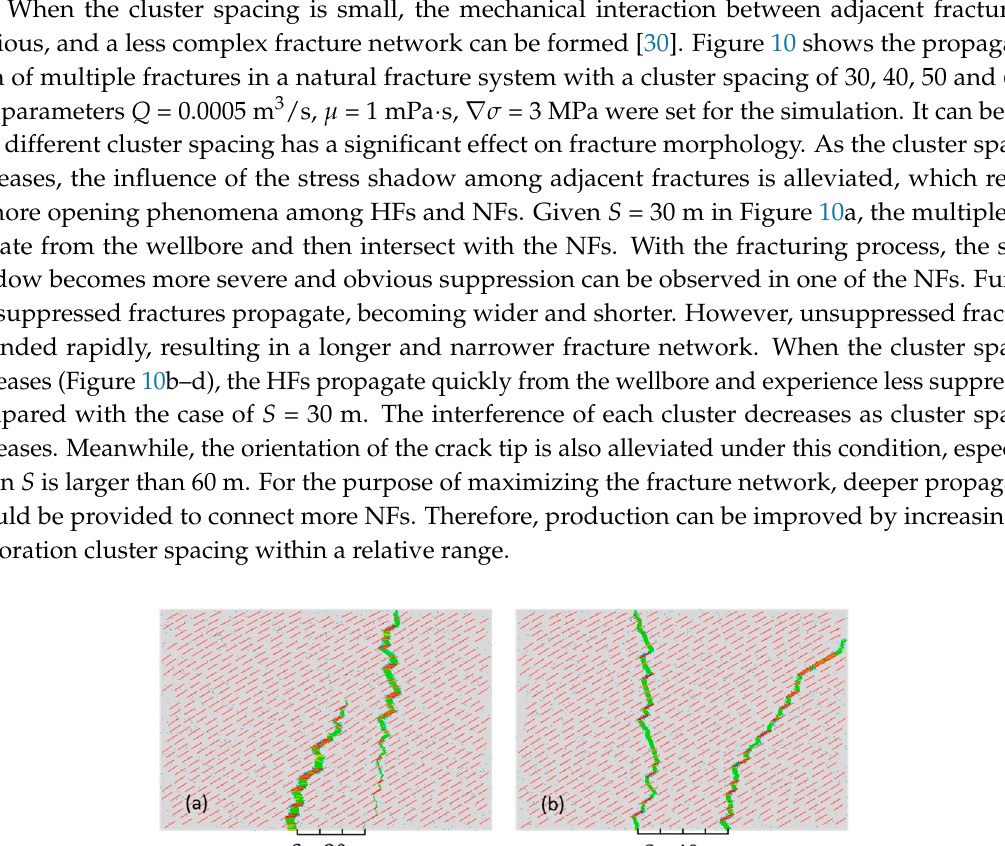
Figure 11. Fracture network lengths at different cluster spacing distances. 3.4. Injection Rate of Fracturing Fluid The influence of the fracturing fluid on the geometric shape of HFs can be expressed by the injection rate and fluid viscosity. In this section, the influence of the injection rate is discussed. It is concluded that by increasing the injection rate, the fluid injection pressure increases [4]. Owing to a high propagation pressure, HFs have more chance to pass through NFs and tend to form lager planar hydraulic fractures [33]. A pre-existing fracture system with random lengths and an approaching angle of 60° was introduced to investigate the influence of injection rate on the fracture network. The stress difference, fluid viscosity and cluster spacing remained constant at 3 MPa, 1 mPa·s, and 40 m, respectively. As shown in Figure 12, three types of flow rates were used: Q = 0.0001 m 3 /s, Q = 0.0005 m 3 /s and Q = 0.001 m 3 /s. It can be seen that the fracturing of two clusters initiated at the wellbore and reactive NFs at an earlier stage of injection. With the fracturing procedure, the fractures divert in opposite directions at lower injection rates, as shown in Figure 12a,b. However, the morphologies of the two-cluster HFs change less when the fluid rate increases from 0.0001 to 0.0005 m 3 /s. When the injection rate reaches 0.001 m 3 /s, it has a significant influence on the complexity of the fracture network. As shown in Figure 12c, HFs propagate in a straighter manner perpendicular to the horizontal minimum principle stress, which results in more crossing phenomena and a less complex fracture network.